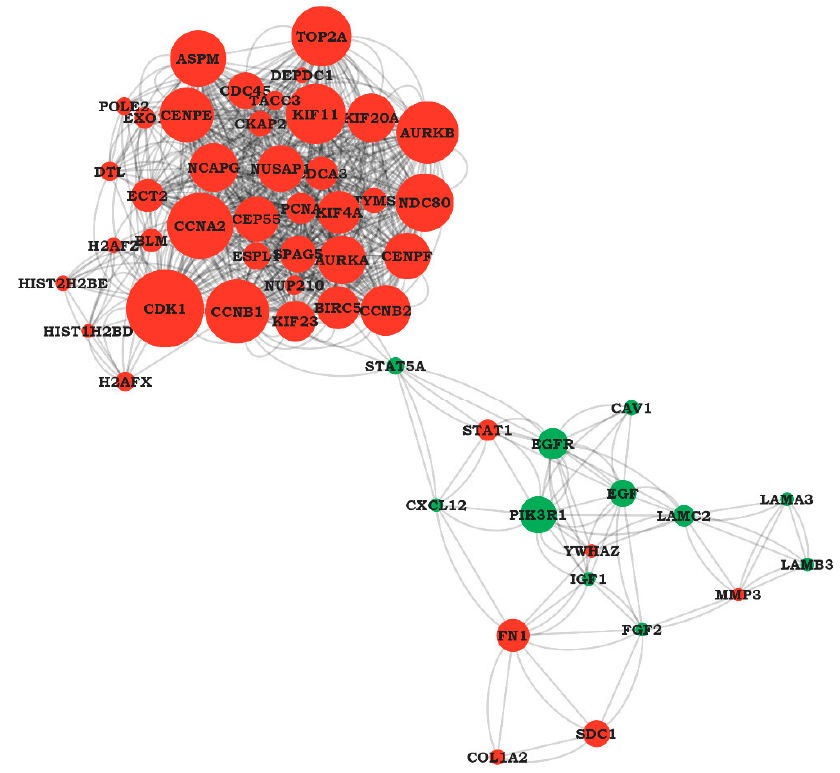
Figure 6. PPI network presentation with red nodes indicating the up regulated genes and green nodes denoting down regulated genes. The node size indicates node degree.